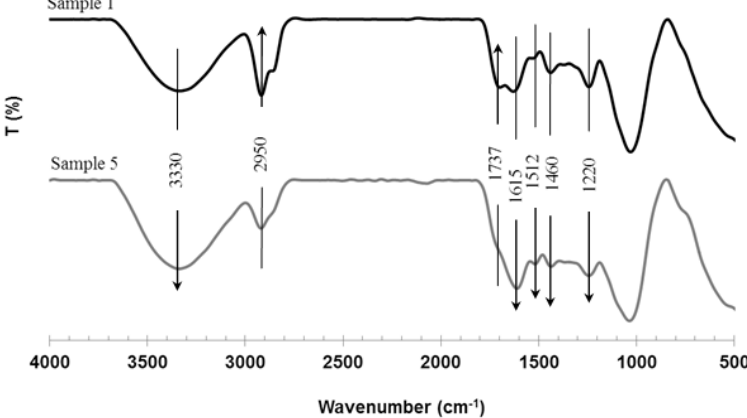
Figure 3. FTIR spectra of the untreated OPMF (1) and SHS-treated OPMF treated at 210 °C for 1 h